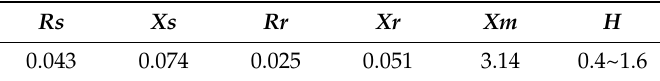
Table 1. Parameters of induction motor